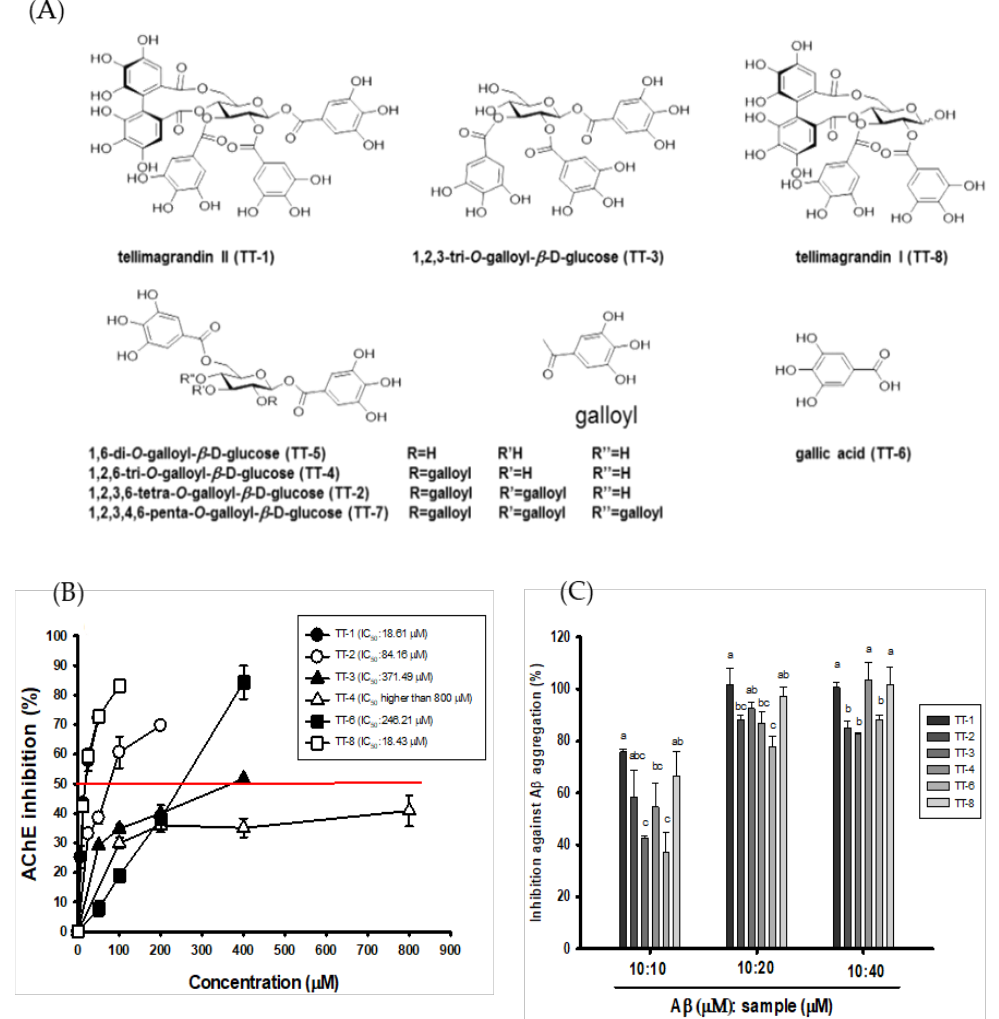
Figure 2. ( A ) The structures of the isolated compounds from TT-hull-50EE; ( B ) Effects of different isolated compounds on acetylcholinesterase (AChE) inhibitory activities; ( C ) Effects of different isolated compounds on anti-A β peptide (1–42) aggregations under concentration (μM) ratios of Aβ peptide to the isolated compound of 10:10, 10:20, and 10:40. The quantitative data were presented as mean ± SD of three independent experiments. Multiple group comparisons were performed using one-way analysis of variance (ANOVA) and the post hoc Tukey’s test. The different lowercase letters in the anti-A β peptide aggregates of purified compounds under the fixed ratio (10:10, 10:20, 10:40) treatment were considered significantly different ( P < 0.05).